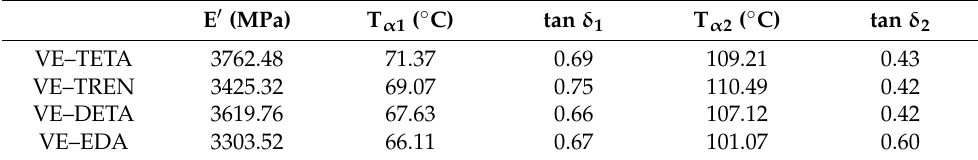
Figure 8. Storage modulus ( a ) and tan δ ( b ) curves of cured bioepoxies with different curing agents. Table 4. Thermomechanical properties of cured